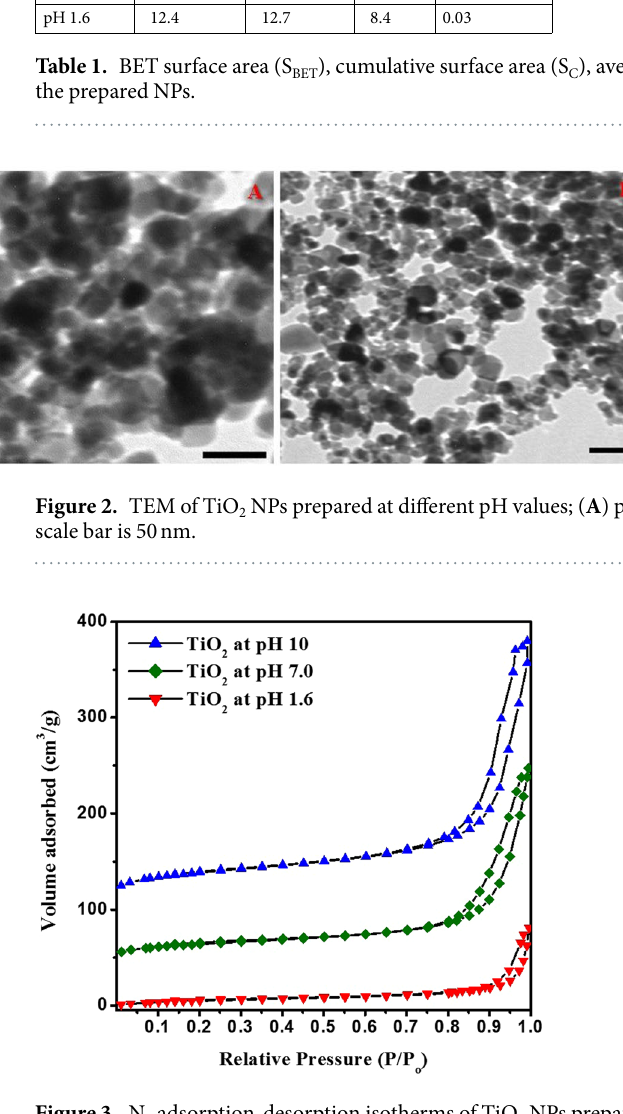
Figure 3. N 2 adsorption-desorption isotherms of TiO 2 NPs prepared at different pH values; 1.6, 7.0 and